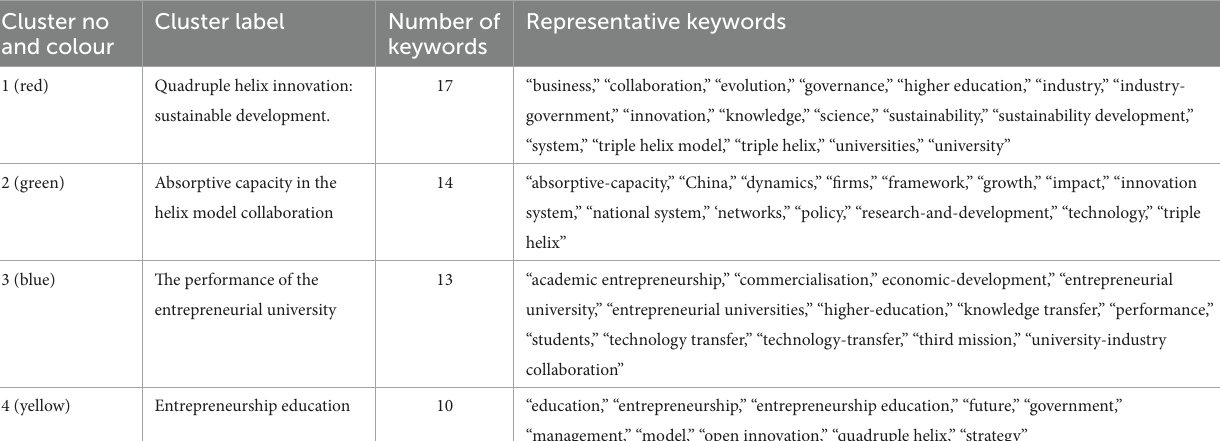
TABLE 7 Co-word clusters on helix model and